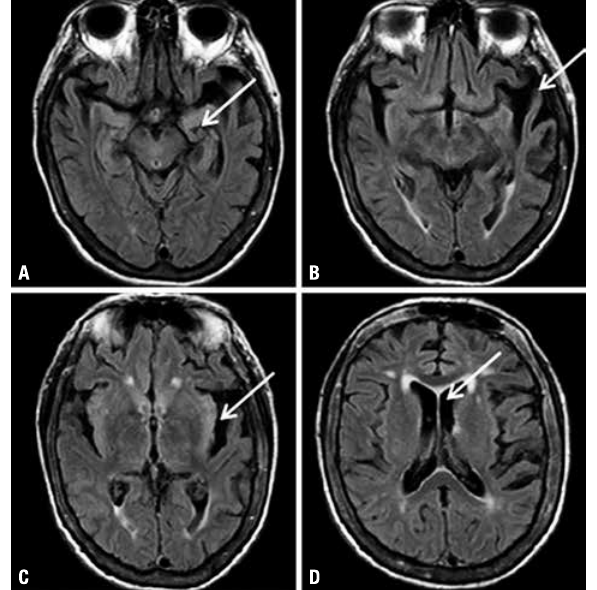
Figure 1. Axial FLAIR brain MRI Image reveals bilateral hippocampal re- duction, predominantly to the left [A]; temporal lobe atrophy and extensive enlargement of Sylvian fissure, predominantly to the left [B and C]; Enlarge- ment of CSF space [D].